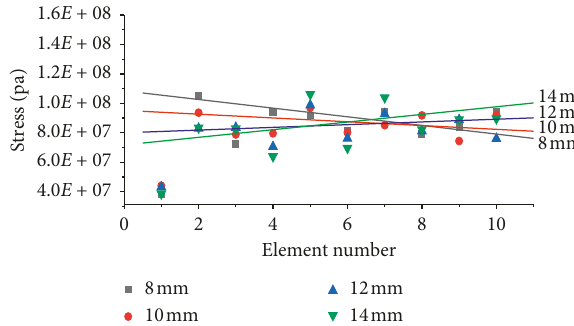
Figure 17: The average stress of representative elements under different cutting depths ( α